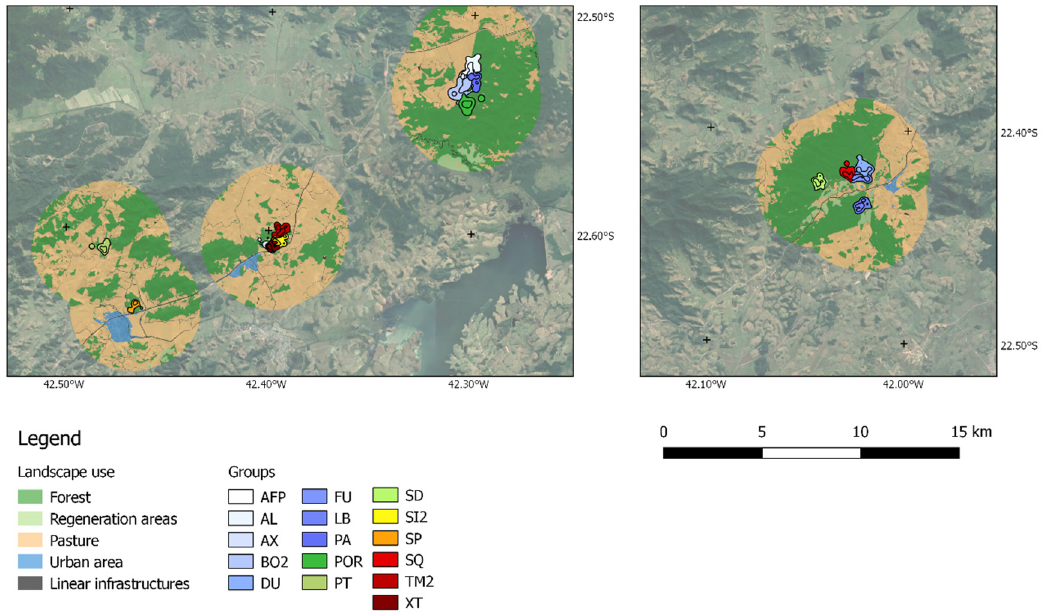
Figure 1. Home range and core areas for the 16 groups of GLTs in three study regions: União Biological Reserve (UN, figure on the right), Poço das Antas Biological Reserve (PA, rightmost fragment on the figure on the left), and isolated patches (intermediate and leftmost fragment on the left figure).